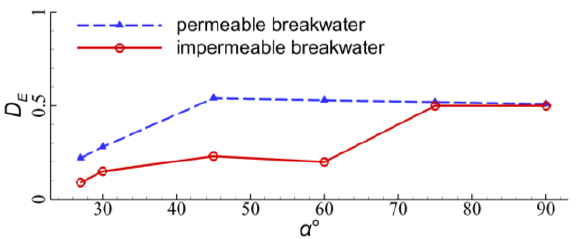
Figure 26. Variation in the total wave energy dissipation rate with slope angle.